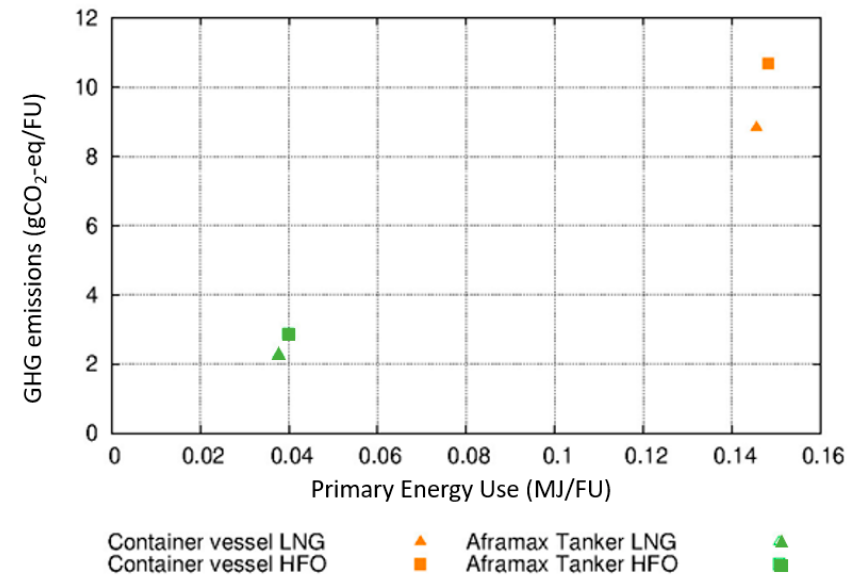
Figure 7. Tank-to-propeller GHG emissions and PEU per tkm for two-stroke engines.